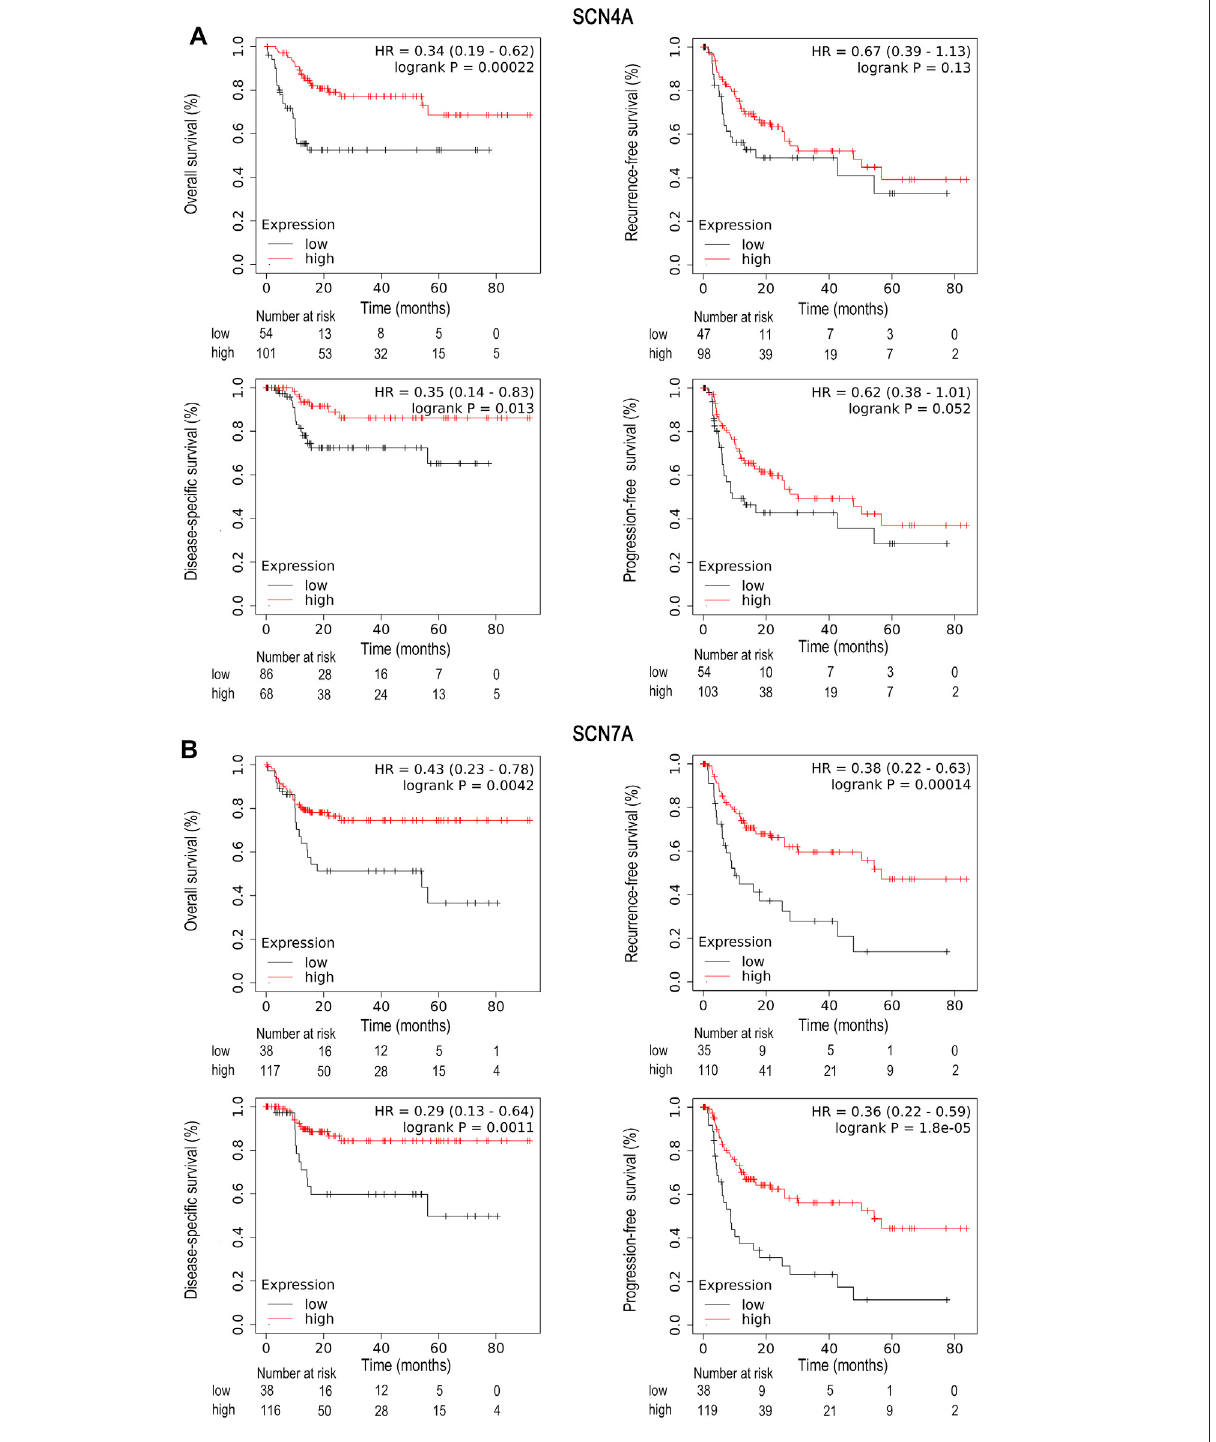
FIGURE3| SurvivalanalysisofSCN4A/7AmRNAinAsiansofHCCbyKaplan – Meierplotter. (A) High SCN4A mRNAexpressionwascorrelatedwithbetterOS( p < 0.001) and DSS ( p (cid:1) 0.013). (B) High expression of SCN7A mRNA was well correlated with better OS ( p (cid:1) 0.004), RFS ( p < 0.001), DSS ( p (cid:1) 0.001) and PFS ( p < 0.001).